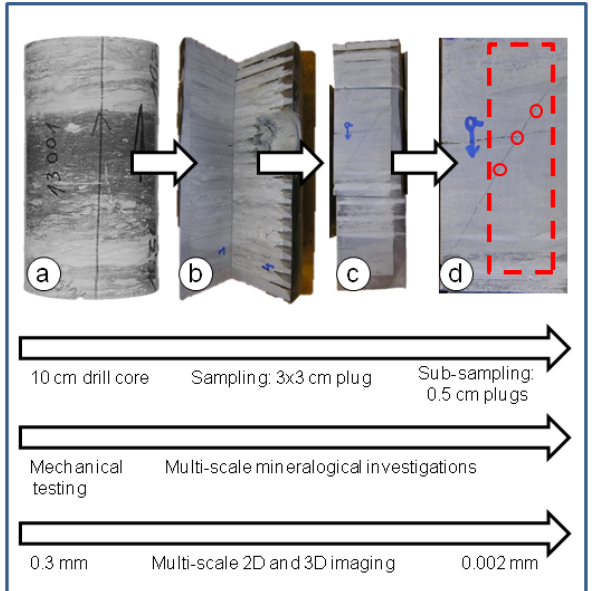
Figure 2. Generalized workflow for the multiple-scale investiga- tions of the Opalinus Clay: from mechanical testing and imaging of the 10cm drill core (a) , to subsampled plugs for mineralogical and higher-resolution imaging (b and c) , to small-scale samples (d) for high-resolution and specific region of interest investigations (red area: subsampling locations).